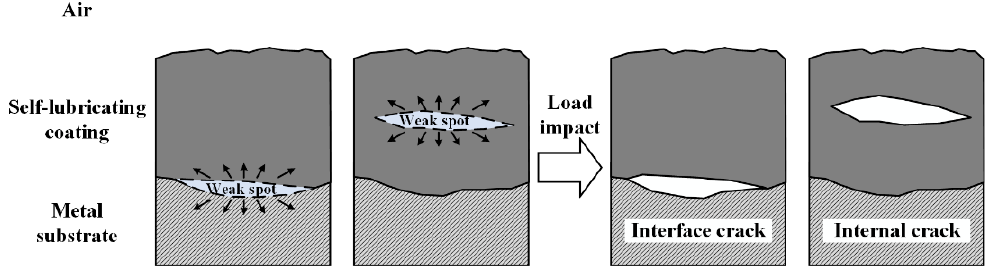
Figure 3. Schematic diagram of self-lubricating coating structure containing crack defects.